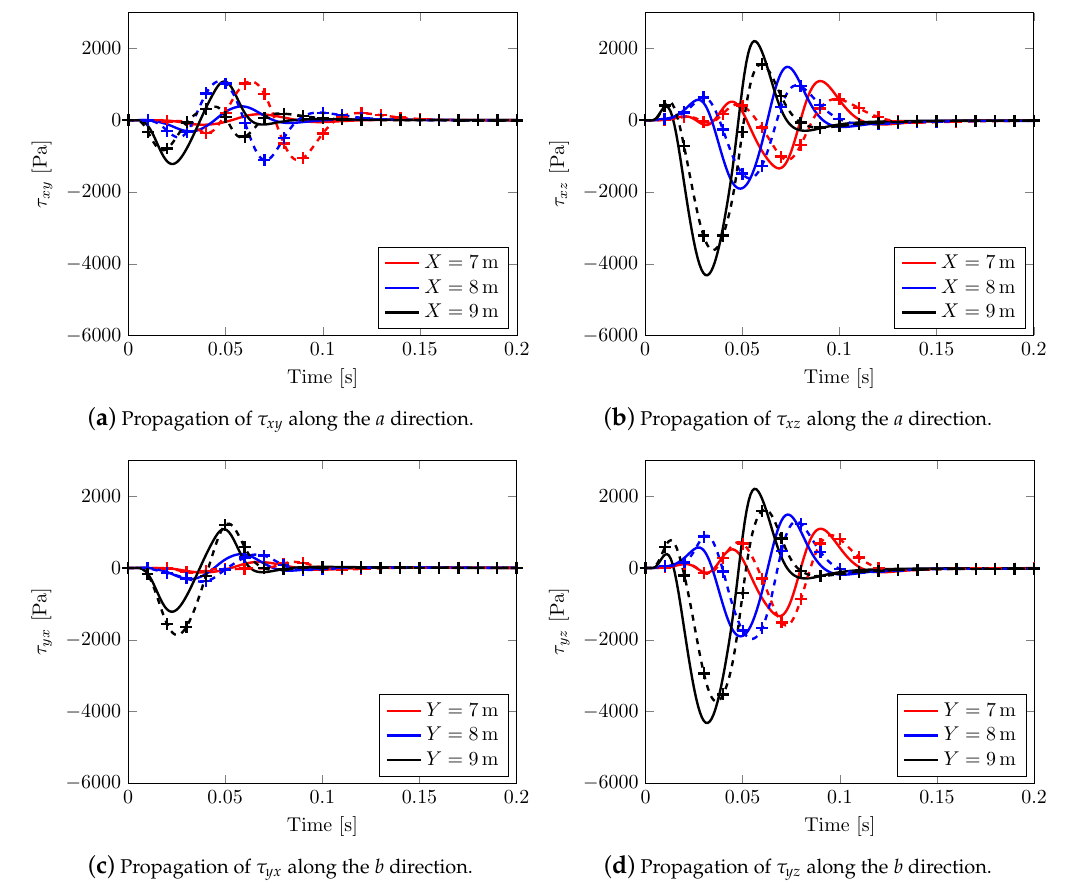
Figure 15. Transversely isotropic soil models. Effective Cauchy stress component calculated along the horizontal directions: solid line for model with α = 0 ◦ , marked line for model with α = 45 ◦